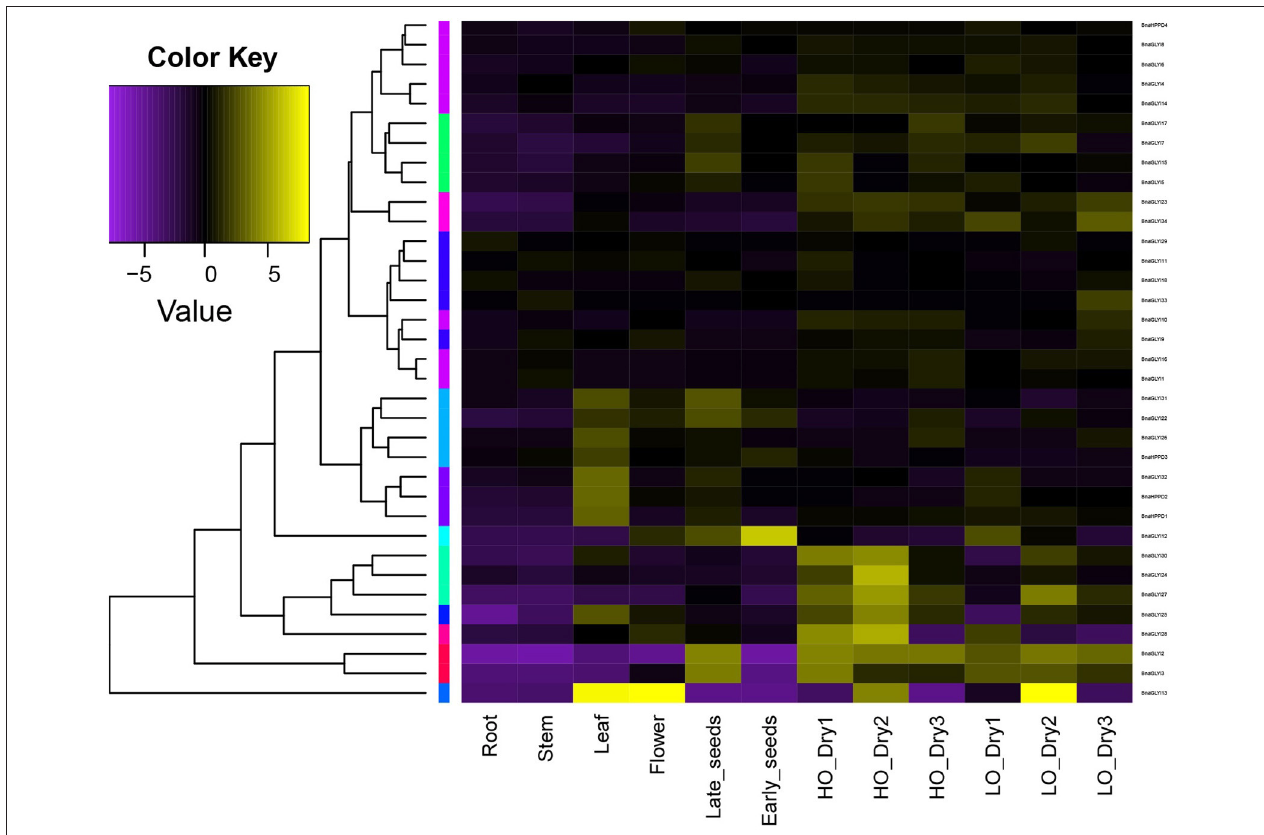
FIGURE 7 | Hierarchical clustering of the expression profiles of BnaVOC genes in different tissues and the seeds in drought stress. The log-transformed values of the relative expression levels of BnaVOC genes were used for hierarchical cluster analysis (original data shown in Table S2). The color scale represents relative expression levels with increased transcript (yellow) or decreased transcript (purple). Late_stage seeds were drought stress treated (HO_Dry1, HO_Dry2, HO_Dry3 indicate high oil content B. napus lines were treated for 1, 2, 3 weeks, respectively; LO_Dry1, LO_Dry2, LO_Dry3 indicate low oil content B. napus lines were treated for 1, 2, 3 weeks,